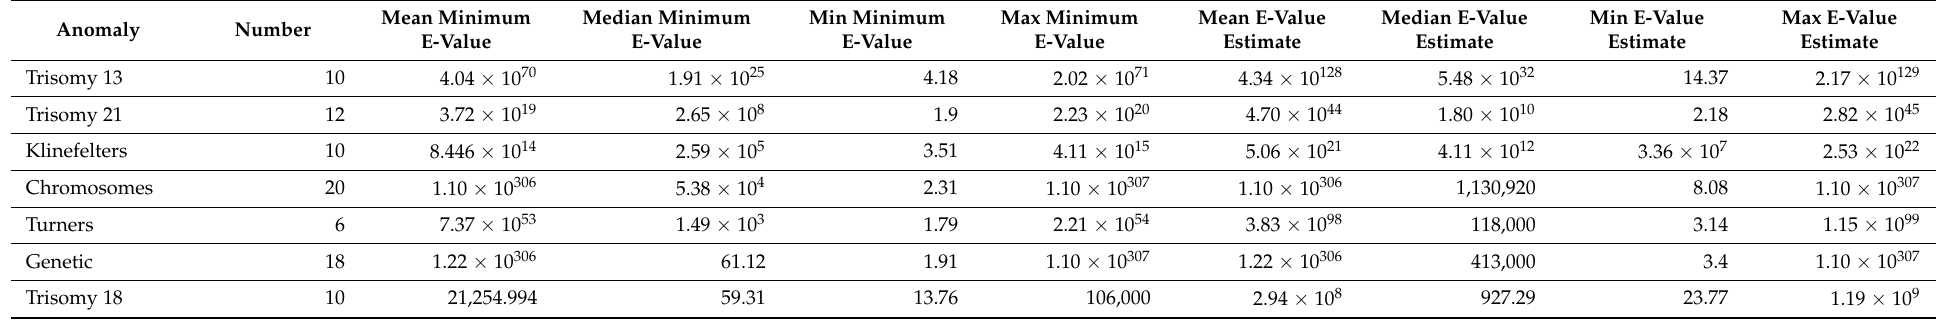
Table 8. Summary of E-Values by